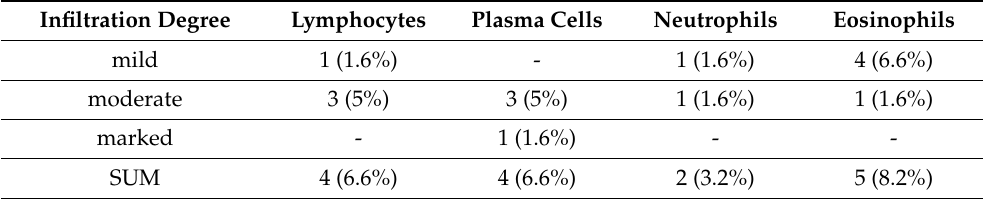
Table 2. Table showing the type of cellular infiltration in the submucosa of the duodenum, along with its degree, number of horses ( n = 60), and % distribution in the studied horse population. Infiltration Degree